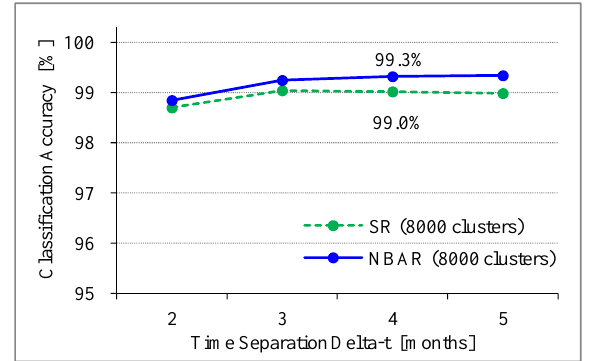
Figure 10. Classification accuracies obtained by time-domain co-occurrence matrix which is defined with 8000 spectral clusters.